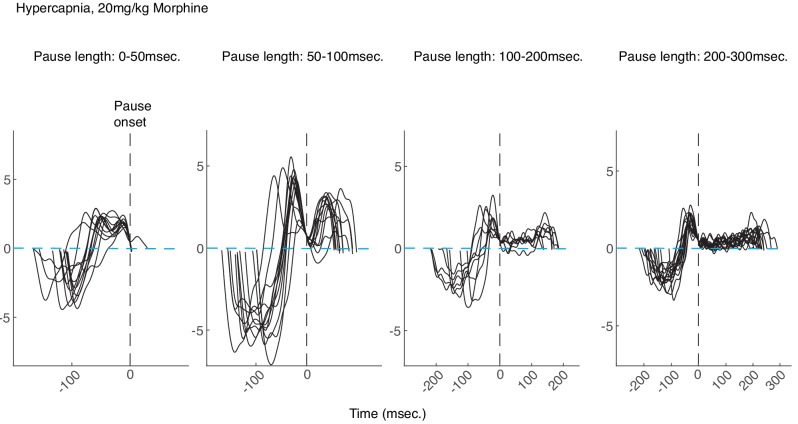
Examples of morphine breaths in hypercapnia binned by pause length.Example breaths binned by pause length (from left to right: 0–50, 50–100, 100–200, and 200-300msec.) from a control animal breathing in hypercapnia after intraperitoneal injection of 20 mg/kg morphine. All breaths are aligned at the onset of the pause (vertical dashed black lines). Note that for longer pauses, the airflow is nearly 0 (dashed blue line) for tens to hundreds of milliseconds and then ends in an increased expiratory airflow, likely active expiration induced by hypercapnia.